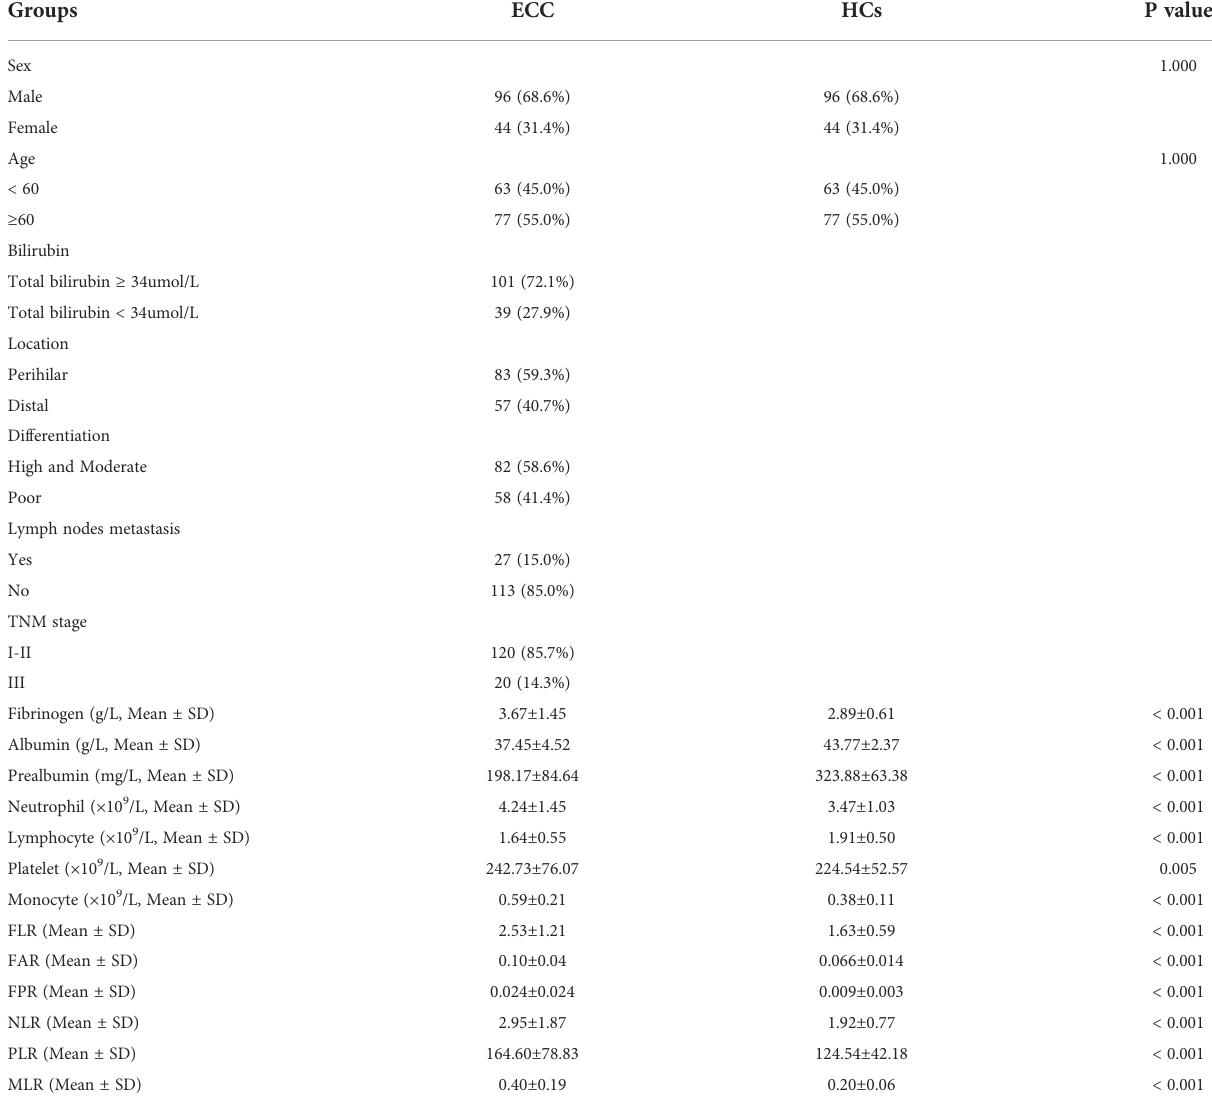
TABLE 1 Clinicopathologic characteristics and circulating in fl ammatory markers in patients with ECC and HCs. Groups